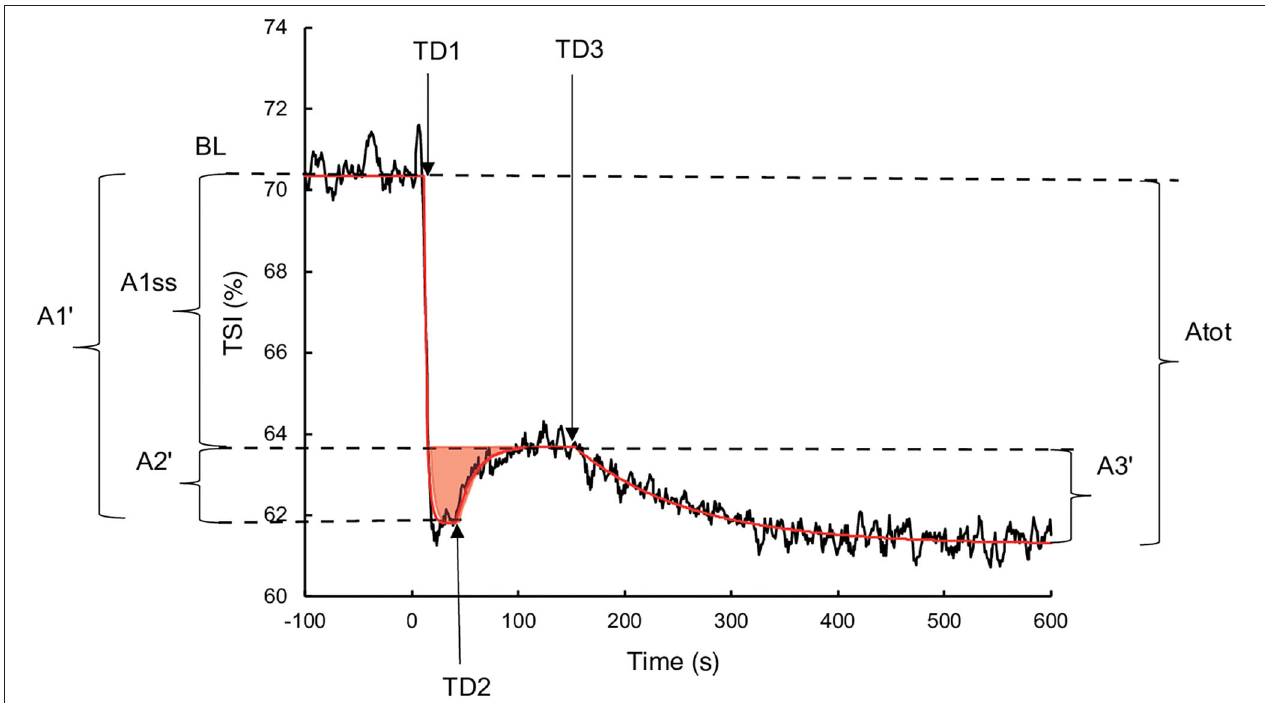
FIGURE 1 | Illustration of the three components of TSI kinetics for a representative subject during exercise without occlusion. The black line represents the TSI measurement, and the red line corresponds to TSI modelling. The red surface represents the TSI overshoot. BL: Baseline; A 1 ′ , A 2 ′ , A 1 ss ′ , A3’, and A tot : amplitudes of phase 1, phase 2, steady state, phase 3, and total response, respectively; TD 1, TD 2, and TD3: time delays of phase 1, phase 2, and phase 3, respectively.